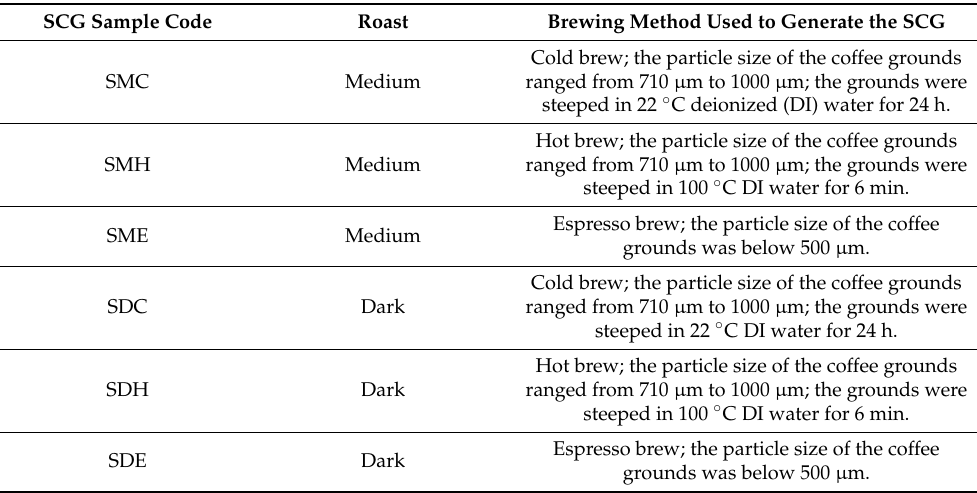
Table 1. Sample Code by Variation in